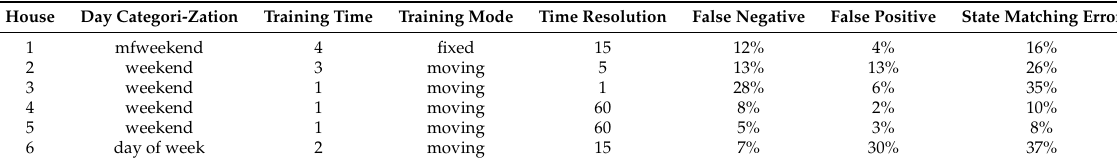
Table 4. Best occupancy prediction model for each